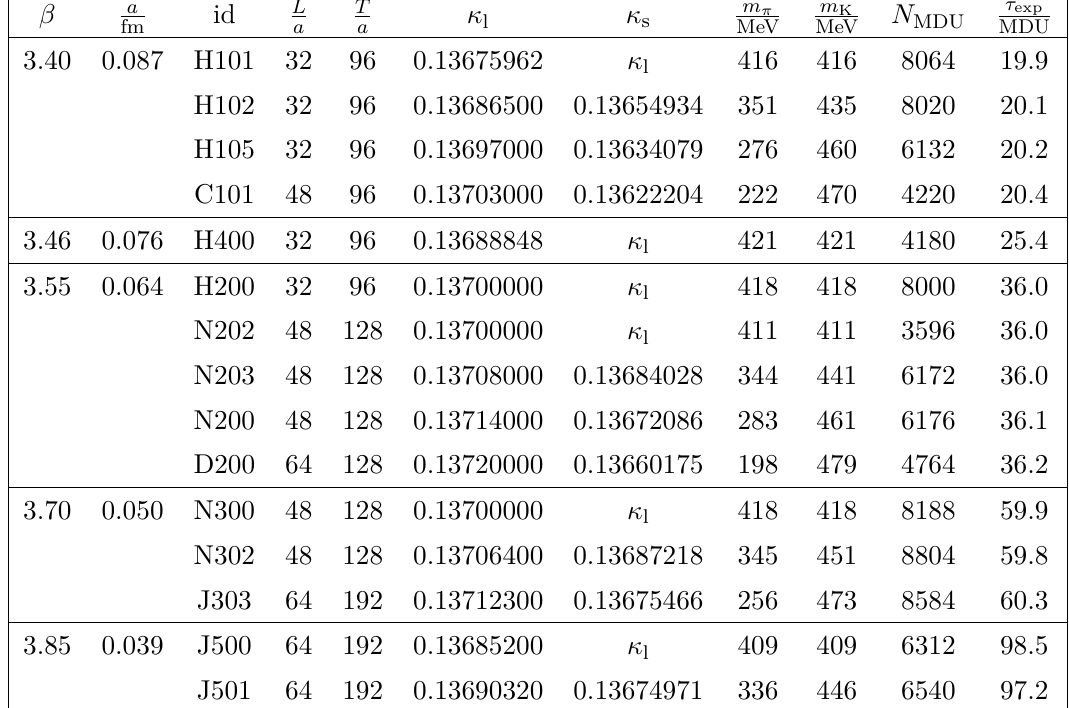
Table 1 . Overview of the gauge field configuration ensembles (labelled by ‘id’) used in this study. We list the geometry ( T × L 3 ) and the bare parameters of the action as well as the resulting approximate lattice spacings and meson masses. The statistics included is quantified by the number of molecular dynamics units N . We performed measurements every 4 MDU except for J303 MDU and J500, where the spacing between two measurements is 8 MDU. The exponential autocorrelation time is defined from t as given by eq. 0